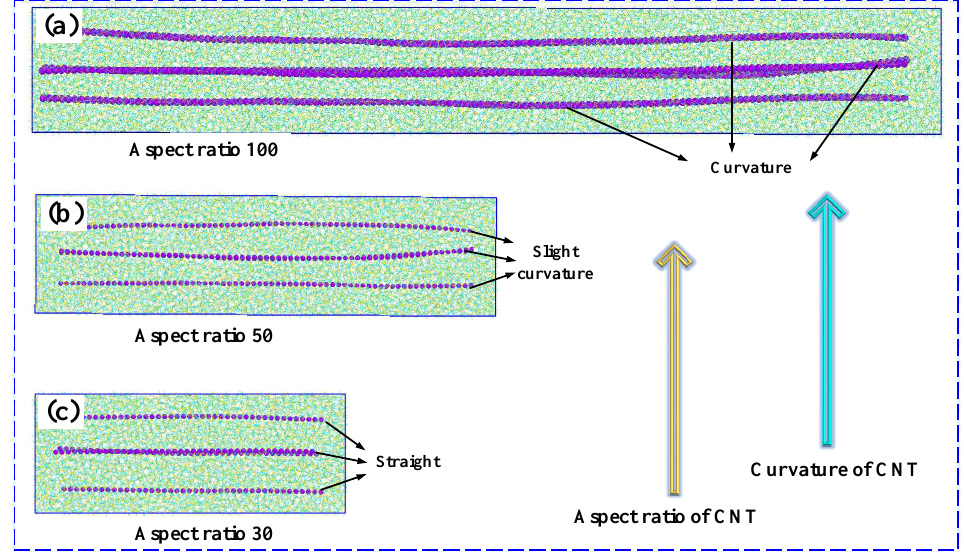
Figure 6. Fully relaxed configurations of the CG models of epoxy-matrix nanocomposites, each of whose cells have 4 embedded CNTs, ( a ) the aspect ratio of CNTs is 100, ( b ) the aspect ratio of CNTs is 50, and ( c ) the aspect ratio of CNTs is 30. All the degrees of coarse-graining of the CNTs are chosen as λ = 5